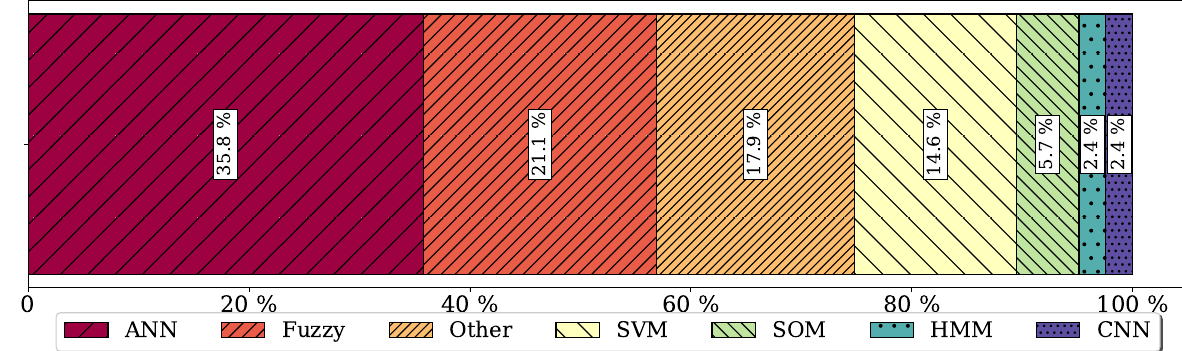
Figure 5. Global repartition by type of